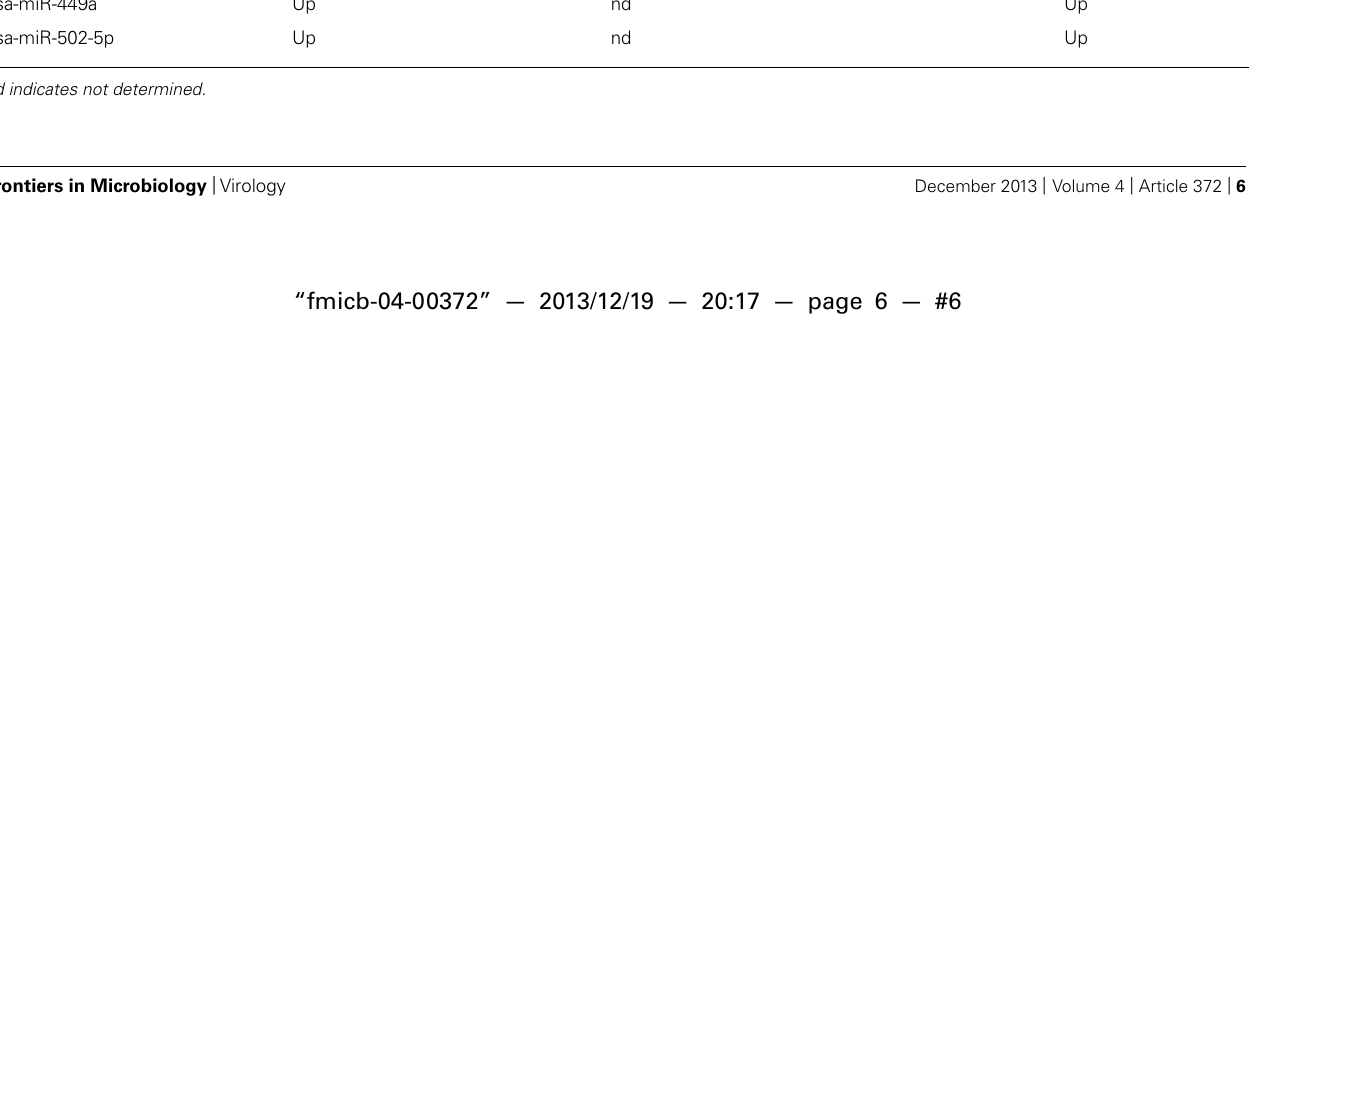
nd indicates not